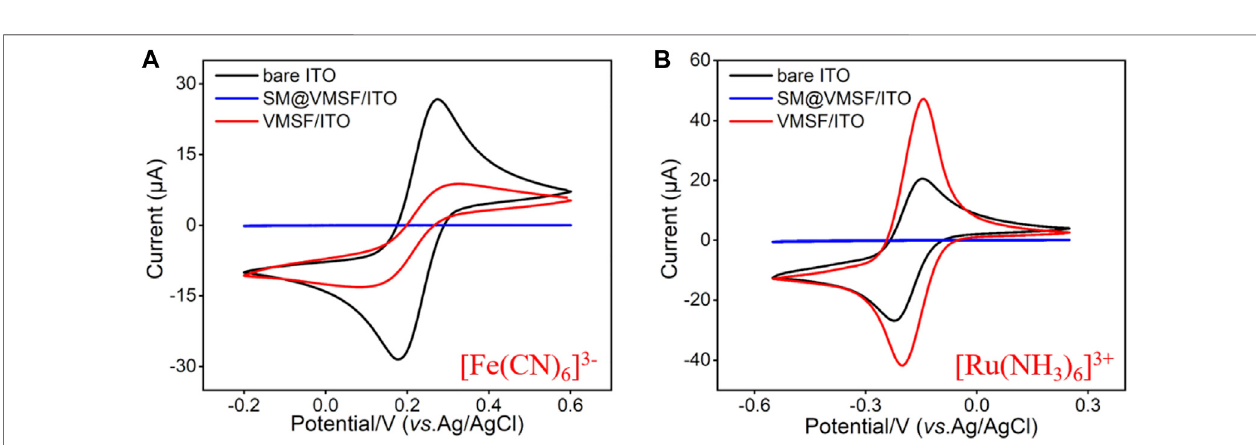
FIGURE 2 | CV curves obtained from the bare ITO, SM@VMSF/ITO and VMSF/ITO electrodes in [Fe(CN) 6 ] 3 − (A) and [Ru(NH 3 ) 6 ] 3+ (B) solution (0.5 mM in 0.05M KHP, adjusted the pH to 7.4). The scan rate was 50 mV/s.